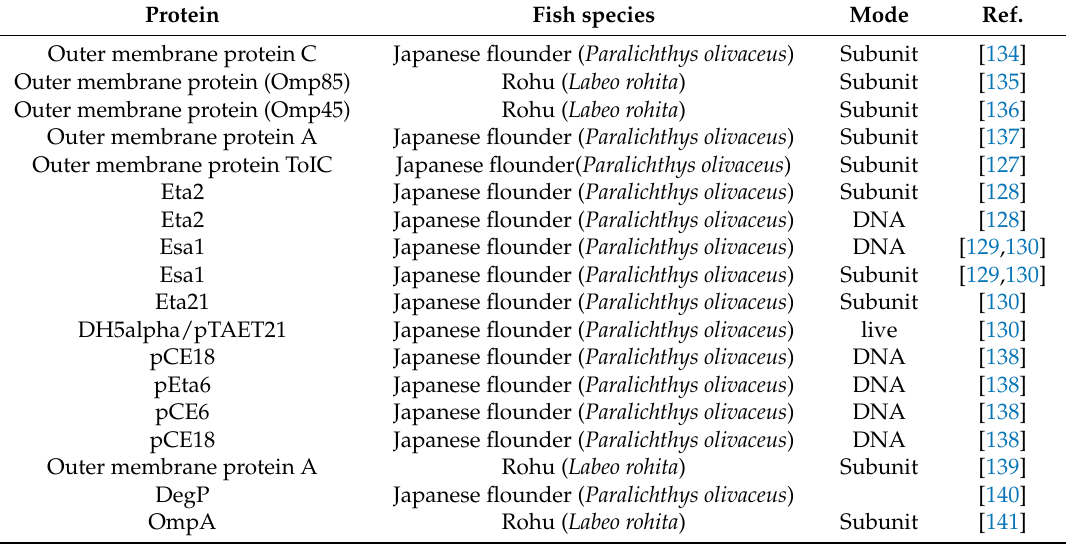
Table 3. Edwardseilla tarda immunogenic proteins used in recombinant vaccine production. Protein Fish species